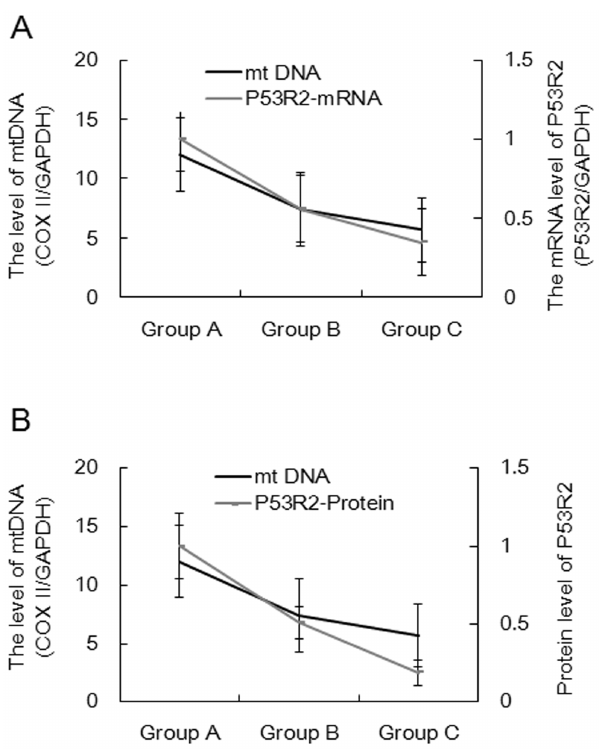
Figure 4. P53R2 reduction parallels mtDNA depletion in PBMCs during longer-term treatment with NRTIs. A: The association between P53R2 mRNA expression and mtDNA copy number in Groups A, B and C. B: The association between P53R2 protein expression and mtDNA copy number in Groups A, B and C.